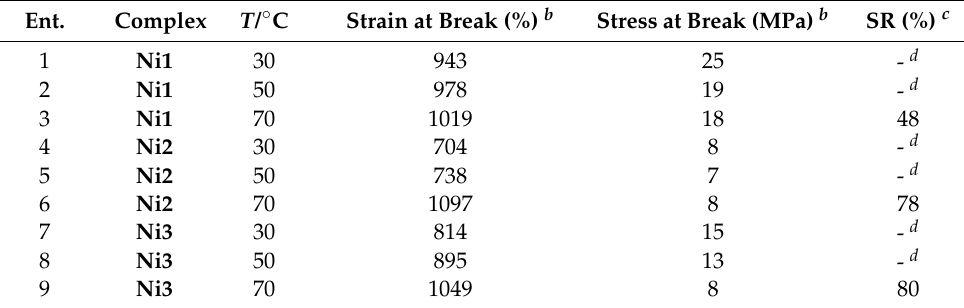
Table 2. Mechanical Properties for Different Polyethylene Samples a .